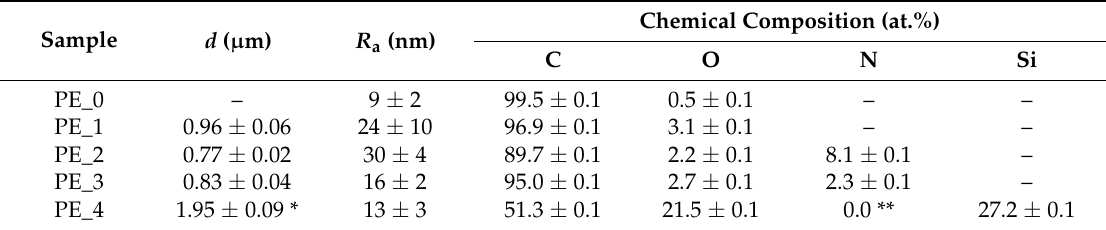
Chemical Composition